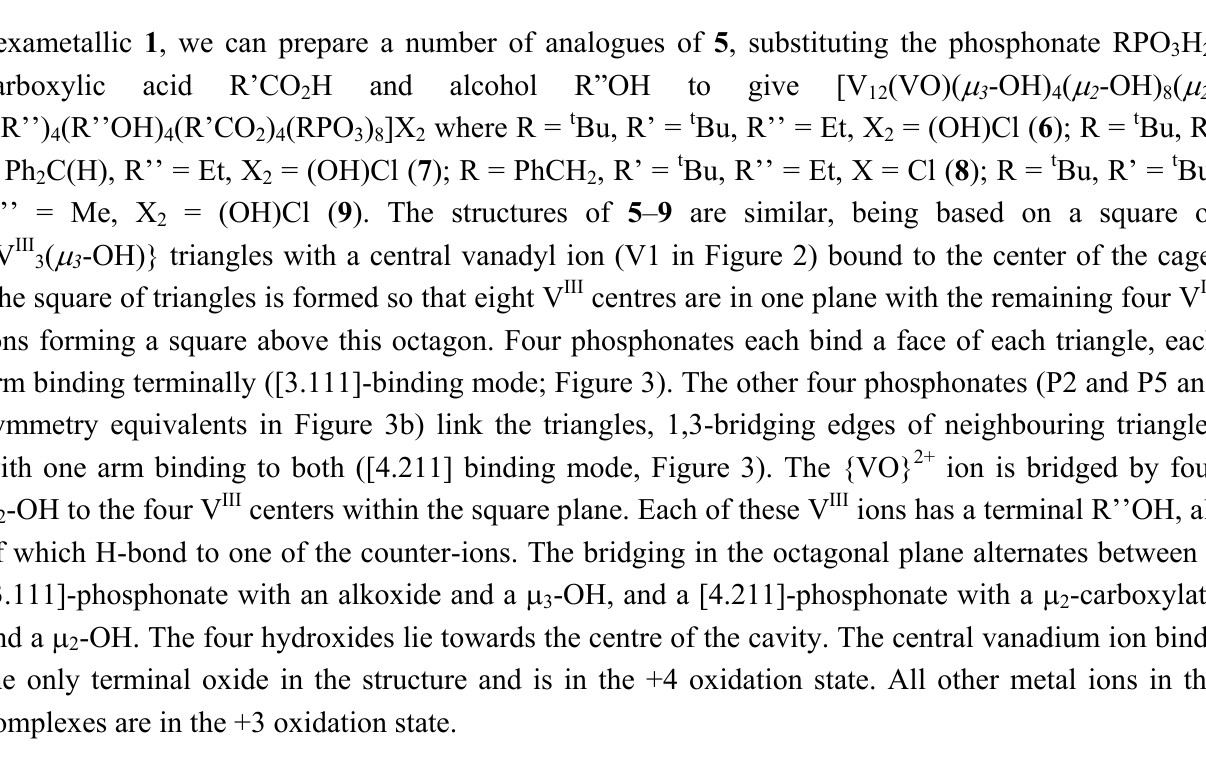
Figure 2. (left) Structure of the cation of 6 in the crystal. (right) “Side-on” view highlighting layered structure. R, R’ and R’’ groups removed for clarity.